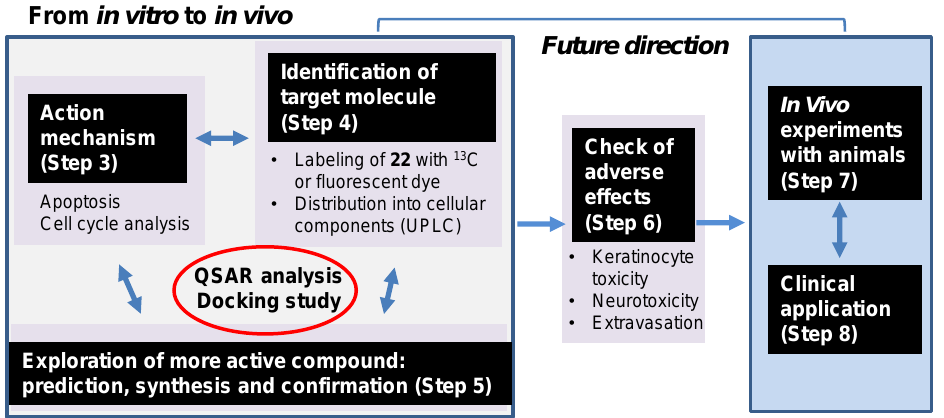
Figure 1. Strategy for exploring new anticancer drugs using chromone backbone